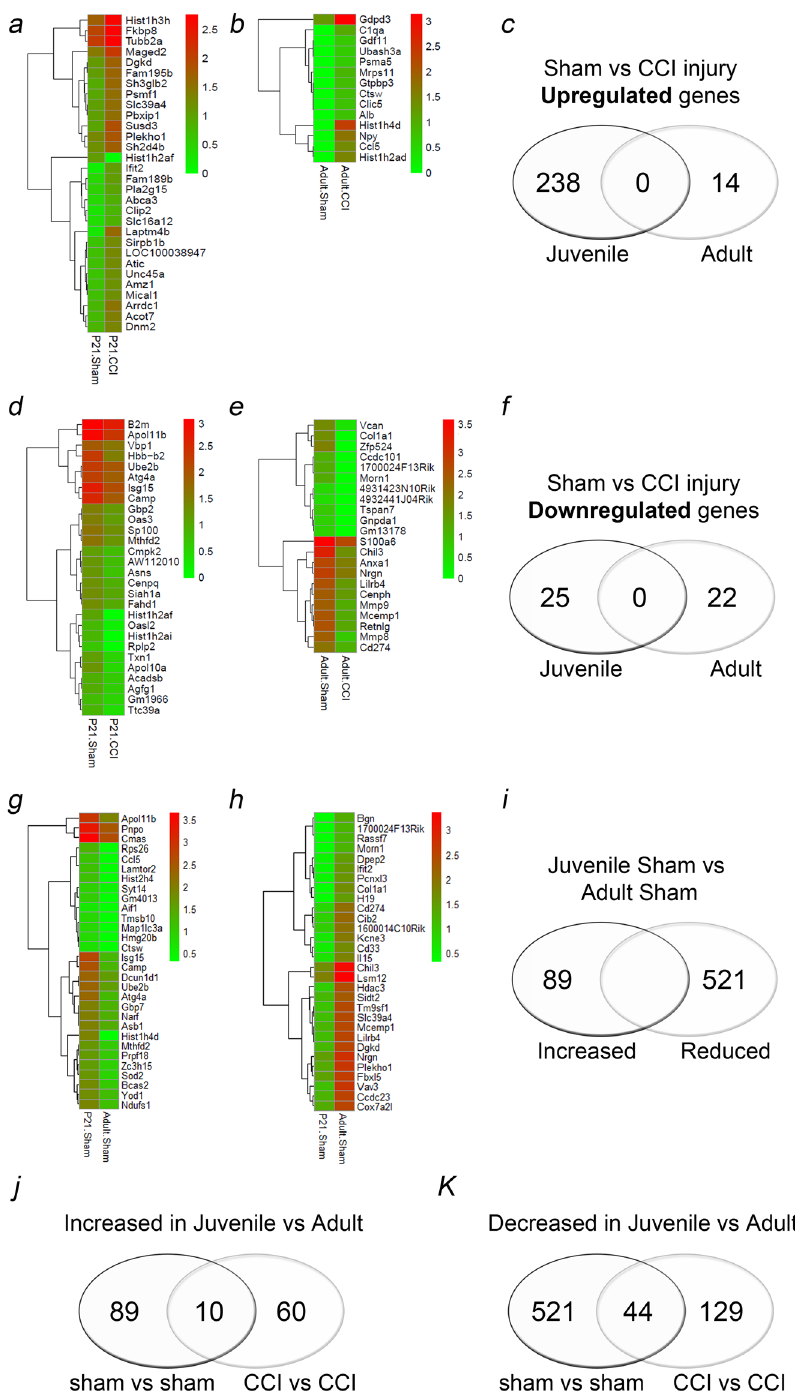
Figure 1. Age-dependent comparative transcriptomic analysis of the peripheral whole blood. ( a ) Heat map of top 30 genes significantly upregulated in the juvenile whole blood at 4d post-CCI injury compared to juvenile sham. ( b ) Identification of Genes upregulated in the adult CCI-injured whole blood compared to sham injury. ( c ) Comparison of genes upregulated following CCI injury in juvenile vs adult whole blood. No upregulated genes were found to overlap. ( d ) Downregulated genes in juvenile CCI-injured and in ( e ) adult whole blood compared to respective shams. ( f ) No downregulated genes were found to overlap. ( g – i ) Comparison of genes found to be significantly increased or reduced in sham juvenile compared to sham adult. ( j ) Genes that were increased in juvenile sham vs adult sham that were also increased in juvenile CCI vs adult CCI samples. ( k ) Genes that were decreased in juvenile sham vs adult sham that were also increased in juvenile CCI vs adult CCI